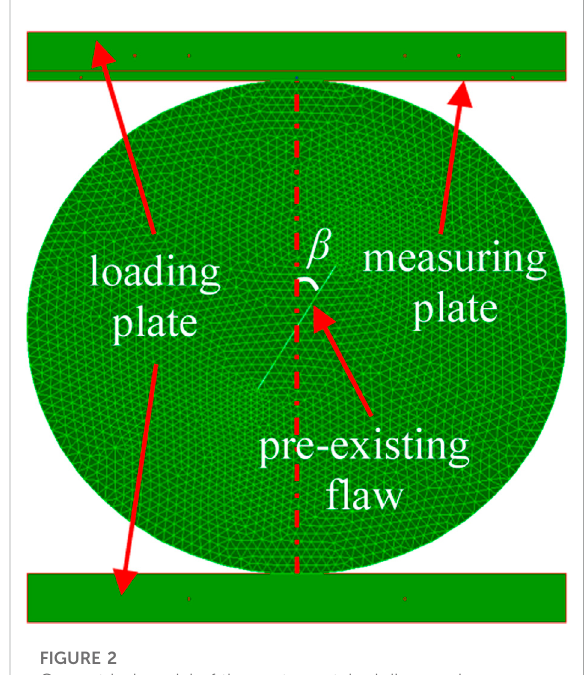
FIGURE 2 Geometrical model of the center-notched disc